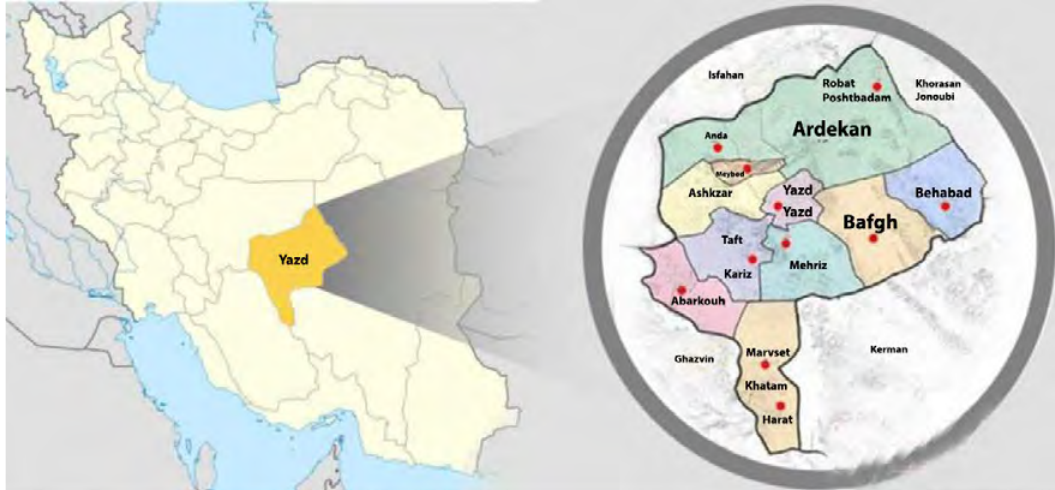
Fig. 1: Location of the study area (Archive of Yazd Cultural Heritage Organization,